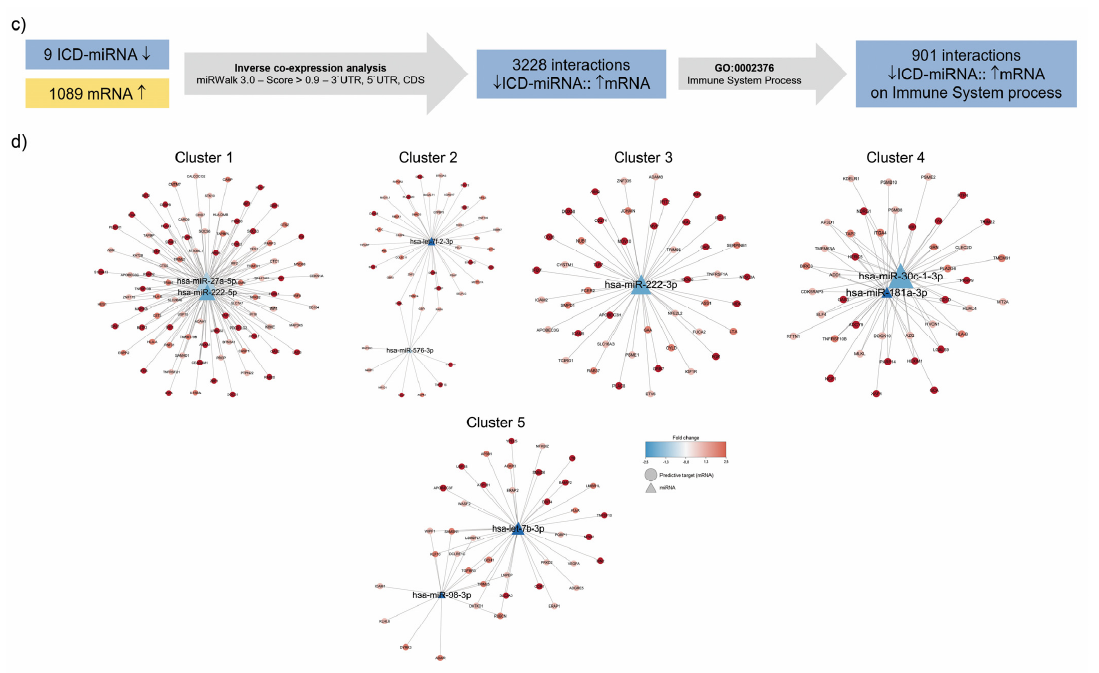
Figure 3. Clustering of immune miRNA: mRNA pairs. ( a ) Identification of inverse co-expression relationship between miRNAs whose expression level was upregulated by ICD inducers, and predictive immune system process-associated targets downregulated by RA/IFN α . ( b ) Clustering analysis was conducted on upregulated ICD-miRNA::mRNA pair. ( c ) Identification of inverse co-expression relationship between miRNAs whose expression level was downregulated by ICD, and predictive immune system process-associated targets upregulated by RA/IFN α . ( d ) Clustering analysis was conducted on downregulated ICD-miRNA::mRNA pair. Table 4. Cluster generation of downregulated ICD-miRNA: mRNA pair. Nodes: Vertices of the network (here, miRNAs and genes). Edges: Connections between the nodes interactions within the network (here, miRNA:mRNA interaction). Modularity: Comparison between the observed and expected number of edges between nodes in the same cluster. Cluster miRNAs Nodes Edges Modularity hsa-miR-27a-5p 1 93 149 hsa-miR-222-5p